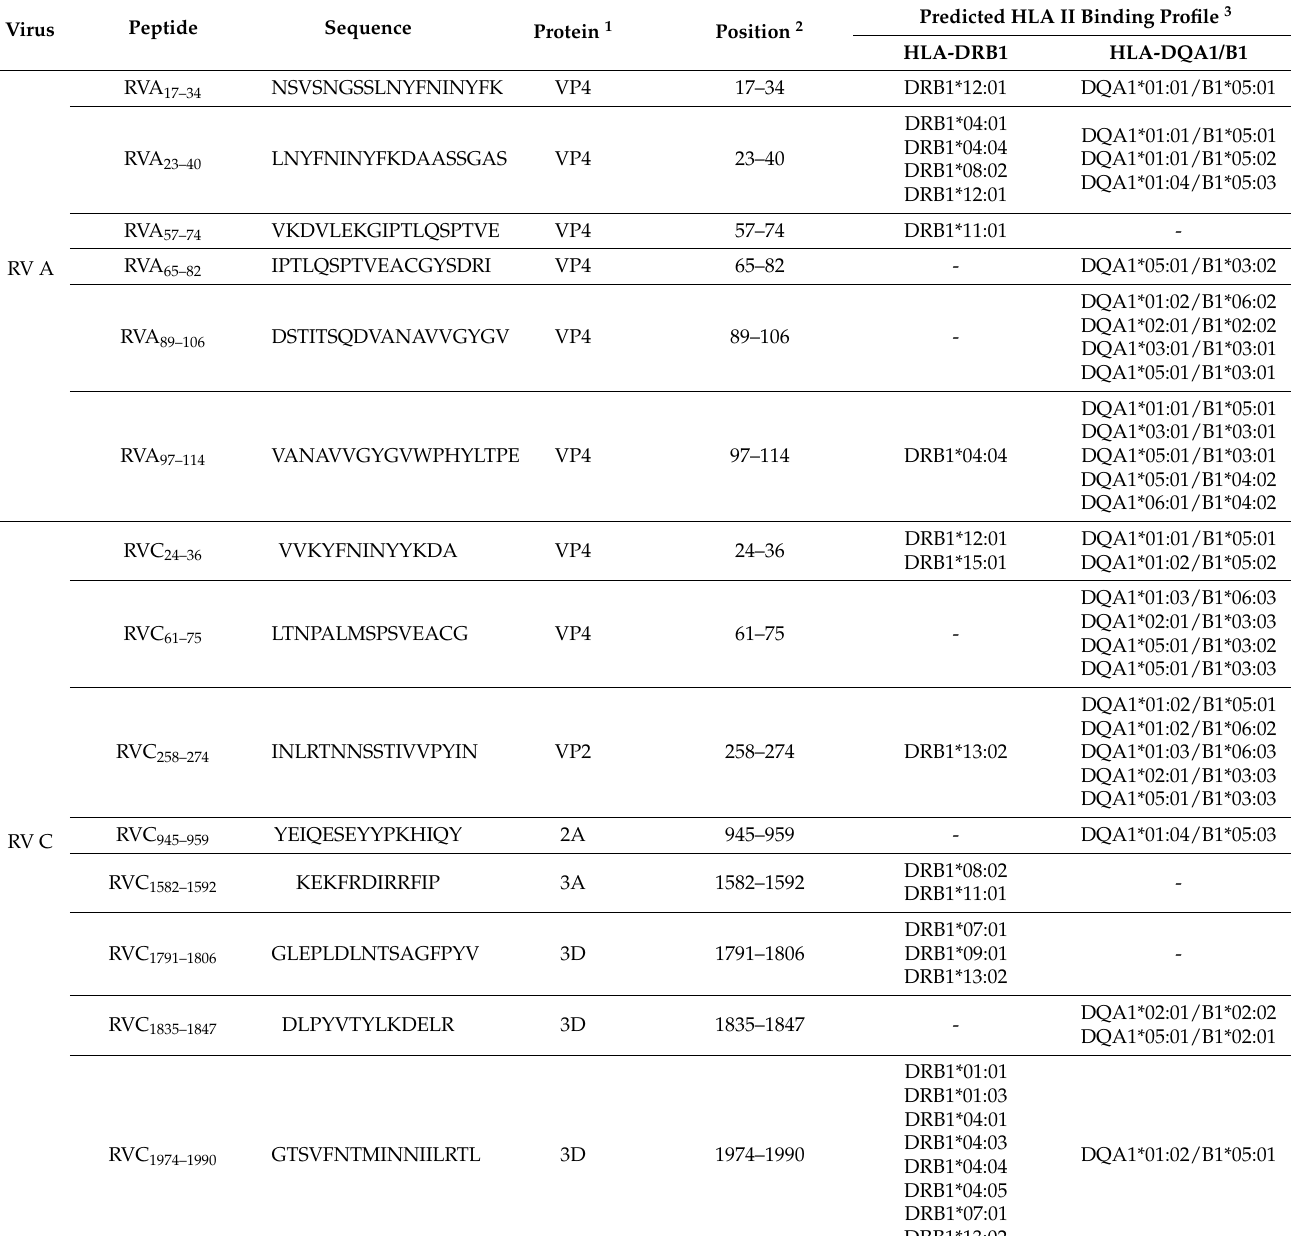
Table 1. Predicted HLA II-binding profile of the RV A and C peptides selected in this study. Virus